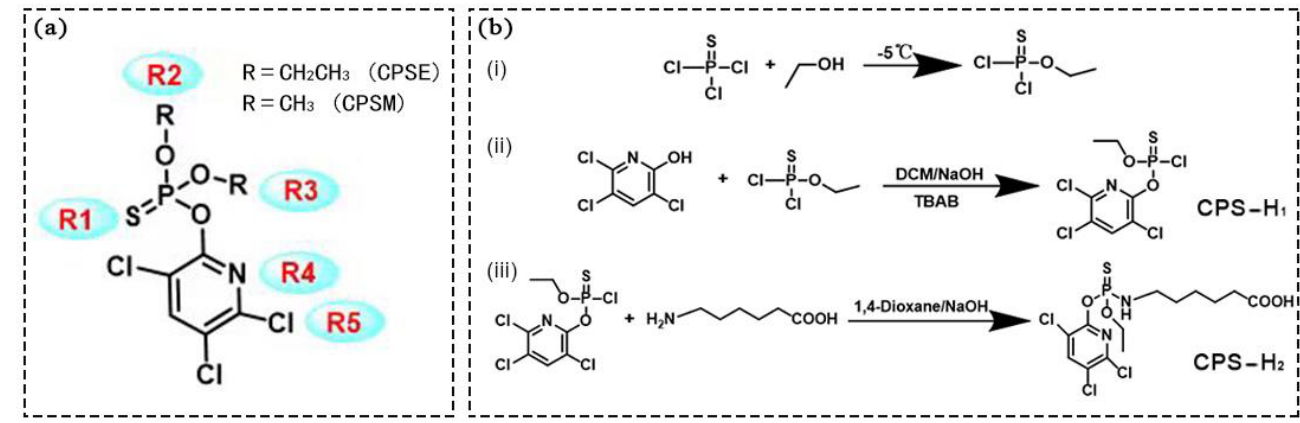
Figure 1. ( a ) Structure of CPS. ( b ) Synthetic route for hapten CPS-H 1 and hapten CPS-H 2 . (i) The synthesis process of O-methyl thiophosphoryl dichloride. (ii) The synthesis process of hapten CPS-H 1 . (iii) The synthesis process of hapten CPS-H 2